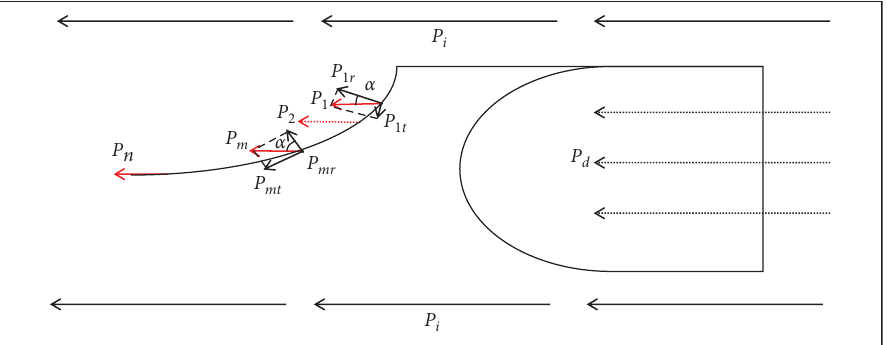
Figure 15: Effect of stress wave on the crack.